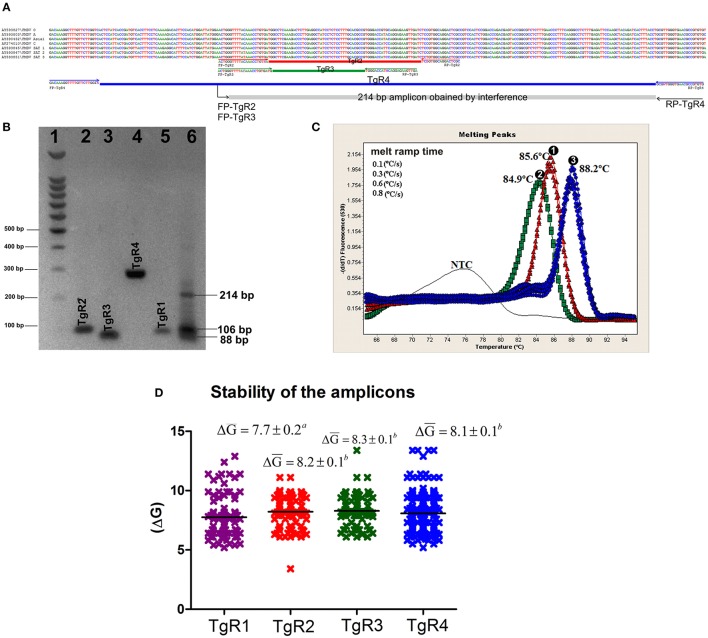
In silico and in vitro evaluation of the amplification products. (A) Alignment of representative sequences of the seven serotypes of FMDV and primer pairs of TgR2, TgR3, and TgR4. The sequence and orientation of each primer is shown. Each amplicon is represented by a colored rectangle, red for TgR2, green for TgR3, blue for TgR4 and gray for the amplicon obtained from the interference of the forwards primes FP-TgR2 and FP-TgR3 with RP-TgR4, the size of this amplicon is also denoted. (B) Electrophoresis in 2% agarose gel, each amplification product obtained is shown, 1- molecular weight marker 100 bp (Promega, Madison, WI, USA); 2- amplicon of the TgR2; 3- amplicon of the TgR3; 4- amplicon of the TgR4, 5- amplicon of the TgR1; 6- amplification products obtained from mix of primer pairs of TgR2, TgR3, and TgR4, the size of the amplification product obtained from of the forwards primes FP-TgR2 and FP-TgR3 with RP-TgR4 is shown, the size of the amplicon is also denoted. For sizes of the amplicons of TgR 1-4 see Table 3
(C) Melting curve analysis of the amplification products obtained from the combination of: 1- primer pair TgR1+ primer pair TgR2, 2- primer pair TgR1+ primer pair TgR3 and 3- primer pair TgR1+ primer pair TgR4 are shown; the specific Tm obtained is also denoted. (D) Stability of the amplification product for each TgR, defined by ΔG media value and standard error associated to each TgR are shown, different letters mean statistical differences (p < 0.05).